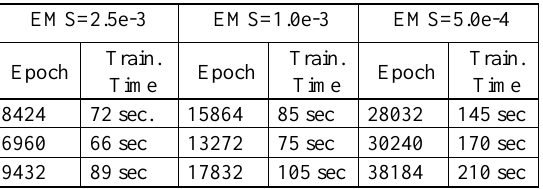
Table 4 Training Indicators of